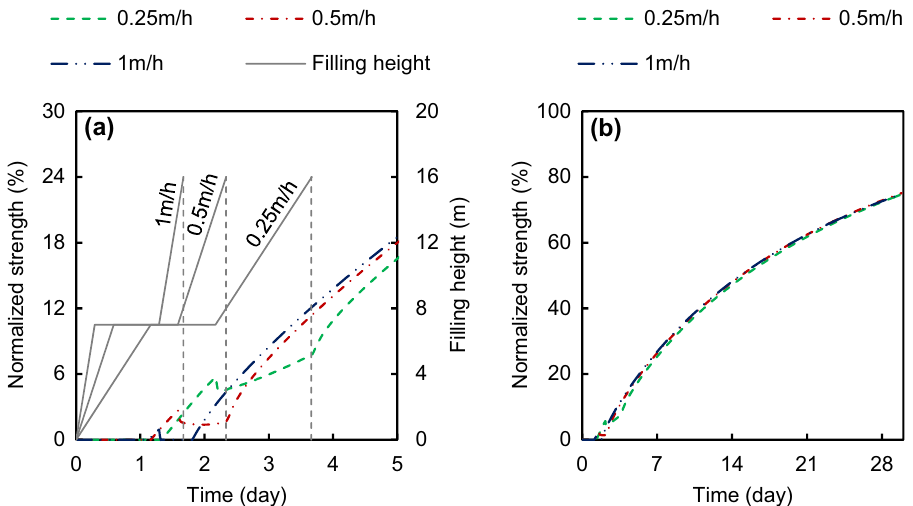
Fig. 21 Effect of filling rate on changes to CPB strength: a filling stage and b post-filling stage.